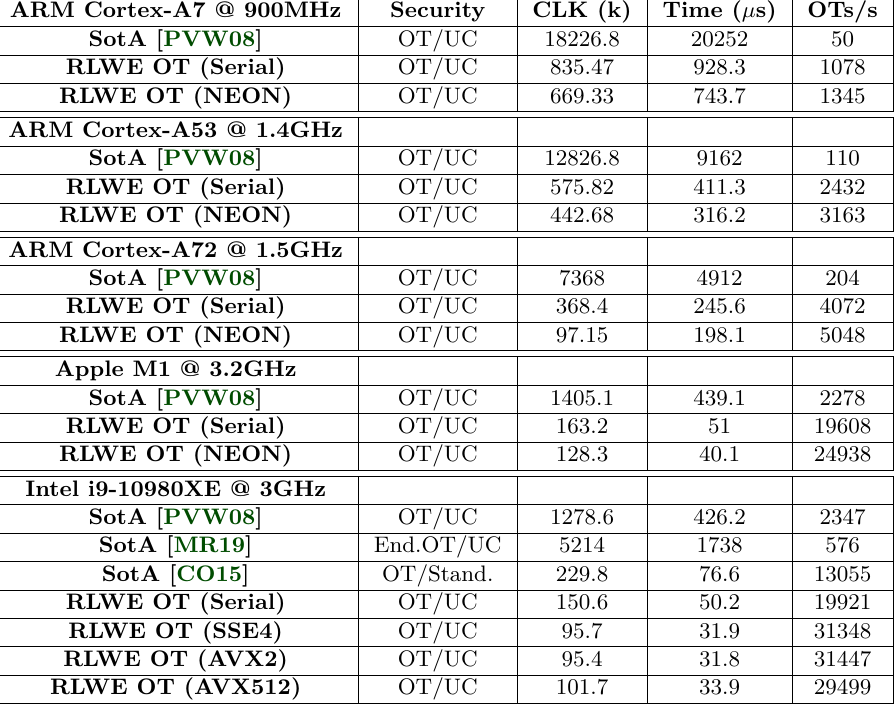
Table 2: Performance evaluation of [BDGM19] using the proposed implementation tech- niques, and state-of-the-art (SotA) implementations [PVW08, MR19, CO15]. ARM Cortex-A7 @